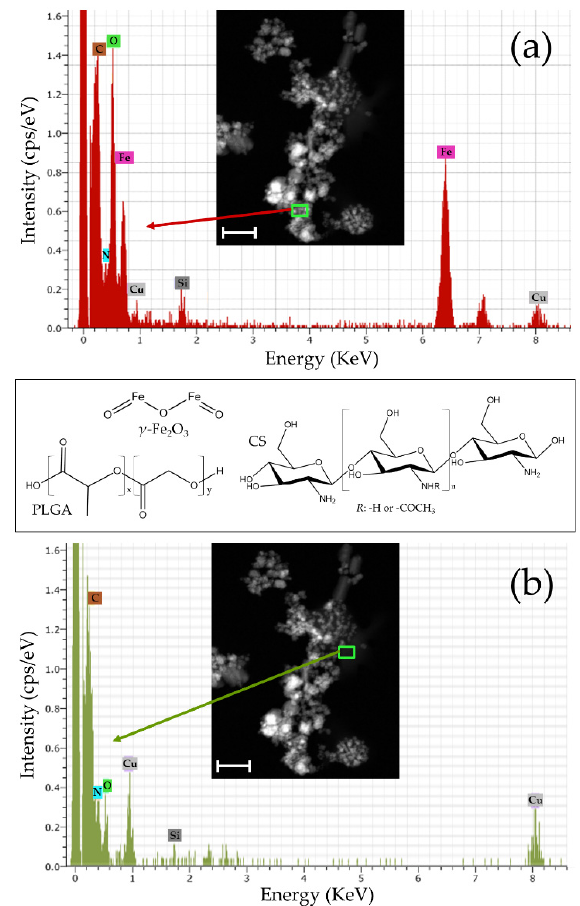
Figure 3. EDX spectra of: ( a ) the centre and ( b ) flank of the (core/shell)/shell NPs. Insets: HAADF-STEM images of these nanocomposites (bar lengths: 100 nm), and chemical structures of γ -Fe 2 O 3, PLGA and CS.